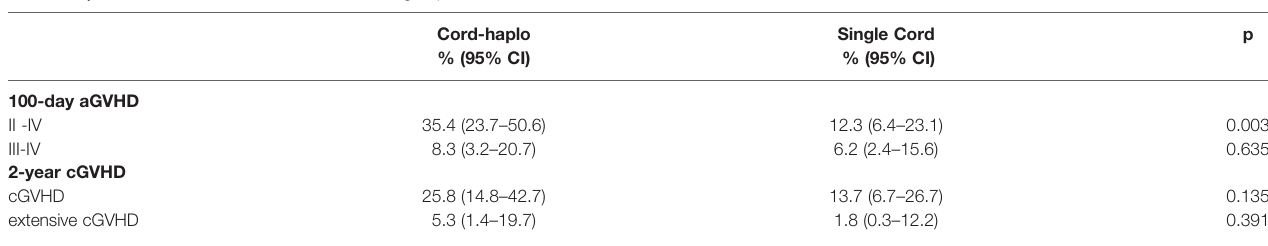
TABLE 4 | Cumulative incidence of GVHD between